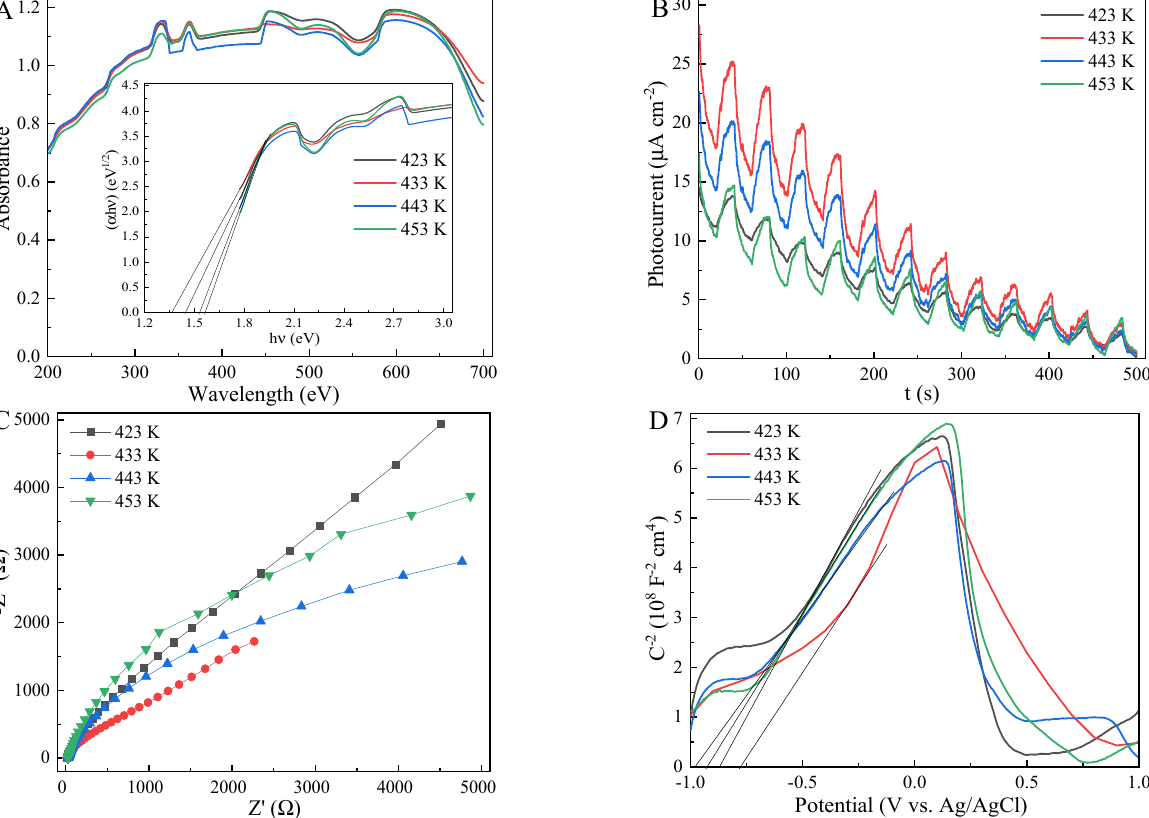
Figure 3. UV-vis DRS ( A ), photocurrent response curves ( B ), electrochemical impedance spectra ( C ), and Mott-Schottky curves ( D ) of MnS treated at different temperatures. For MnS treated at 433 K for 16 h, the split peaks of Mn 2p at 652.99 and 641.31 eV were respectively ascribed to Mn 2p1/2 and Mn 2p3/2 of Mn 2+ , and their corresponding satellite peaks located at 655.29 and 644.39 eV (Figure 4A) [33,59]. The dissected peaks of S 2p at 161.53 and 160.33 eV (Figure 4B) were ascribed to S 2p1/2 and S 2p3/2, respec- tively. However, the tested atomic ratio of Mn/S was lower than 1:1, indicating the for- mation of S defects in octahedral MnS. The Zeta potential plots (Figure S5) indicated that the pH range of 3.00~9.36 and 10.75~11.00 induced to the negative surface discharge of MnS treated at 433 K for 16 h, while the pH range of 9.36~10.75 resulted in the positive surface discharge. Previous works [60,61] reported that TCH had three species, including cationic (TCH 3+ ) at pH < 3.3, zwitterionic at pH of 3.3~7.7, and anionic (TCH − and TC 2 − ) at pH > 7.7, respectively. Hence, the obtained MnS could efficiently adsorb TCH at pH of 3.3~10.75 via the electrostatic attraction, maximizing the adsorption efficiency of TCH [27,38]. PL spectra (Figure 5) suggested that the PL intensity of MnS decreased and then increased with an increase in hydrothermal temperature. For comparison, MnS treated at 433 K exhibited the lowest PL intensity, meaning the efficient transfer and separation of charge carriers. Figure 4. Mn 2p ( A ) and S 2p ( B ) XPS spectra of MnS treated at 433